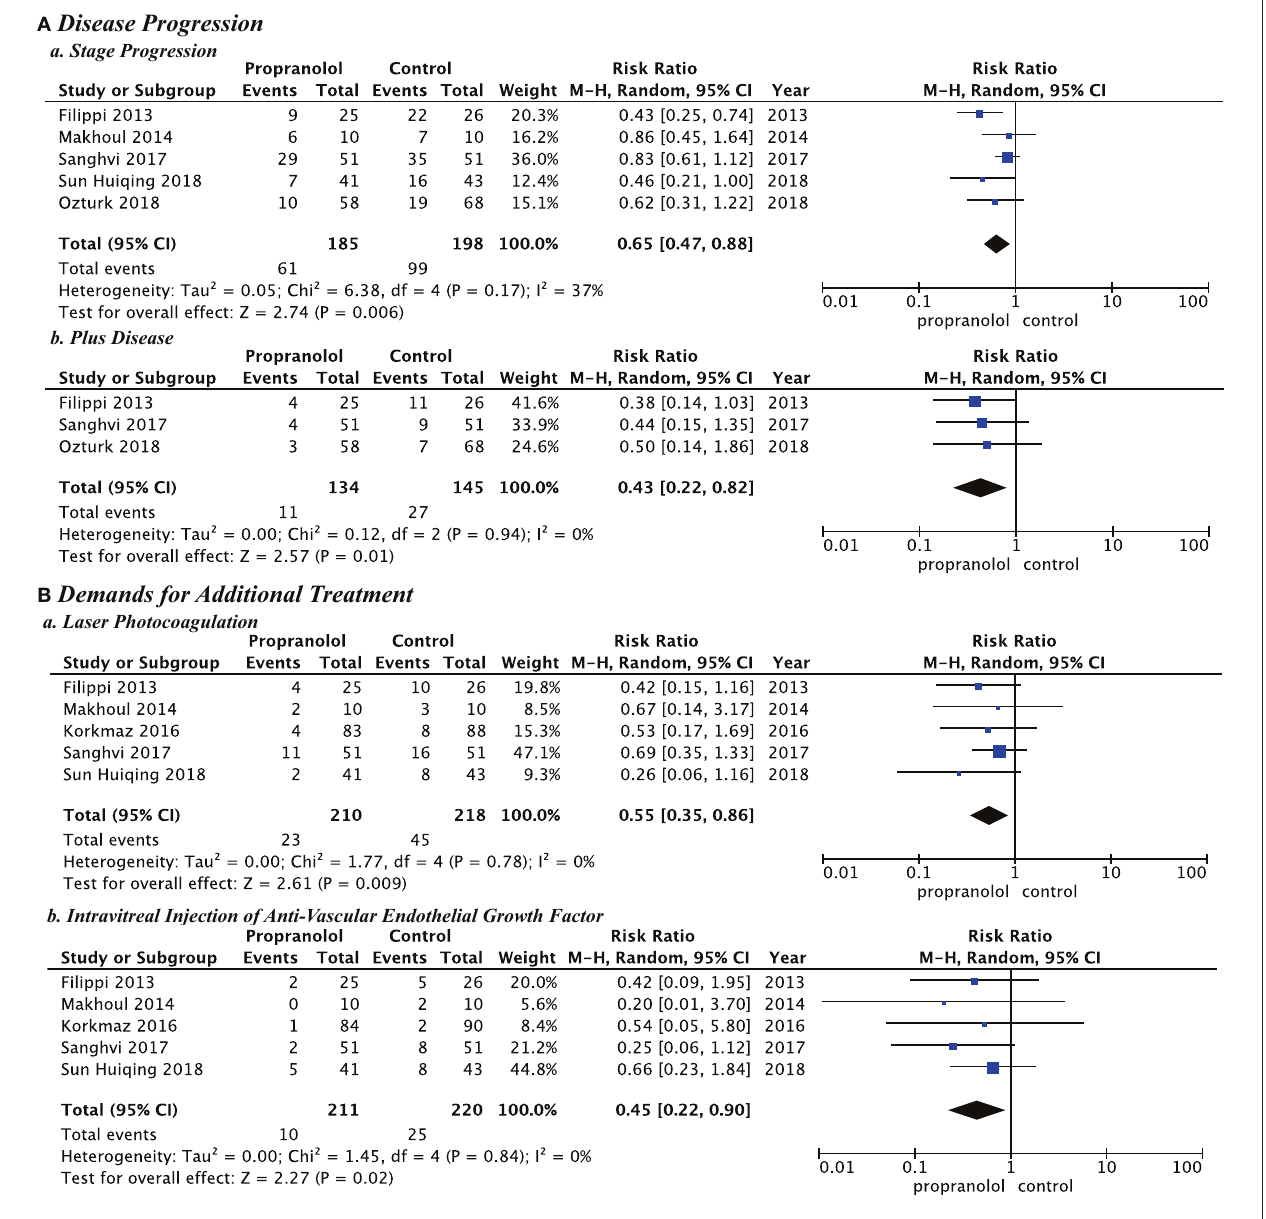
FIGURE 3 | Clinical efficacy of propranolol oral administration in the prevention and treatment of retinopathy of prematurity based on disease progression and the demands for additional treatment. (A) Disease progression and (B) Demands for additional treatment.